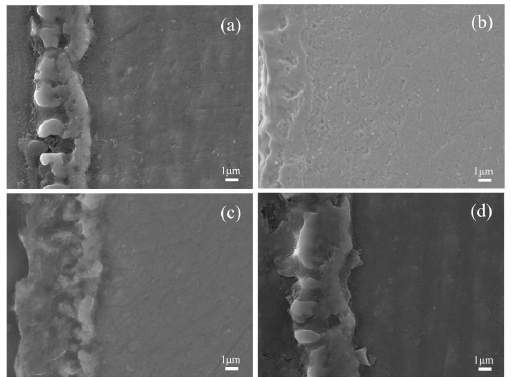
Figure 2. SEM cross-sectional morphologies of various coatings: ( a ) UMAO; ( b ) UMAO / PLGA / BR1.5; ( c ) UMAO / PLGA / BR3.0; ( d ) UMAO / PLGA /